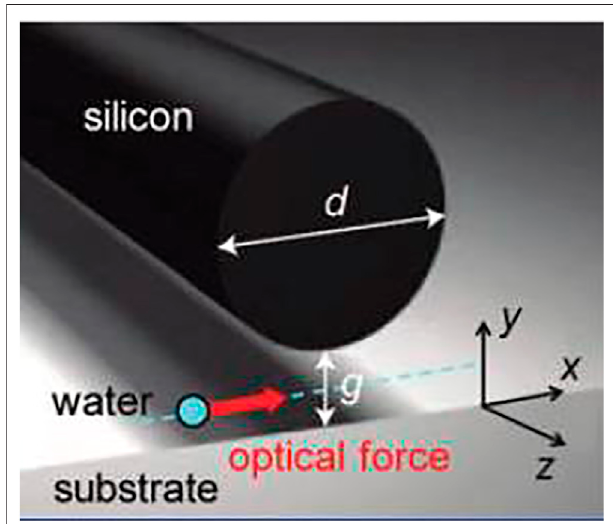
FIGURE 2 | Image showing the silicon waveguide separated by a sub-micrometer gap to a metal substrate, showing the optical force applied to the nanoparticles (Complete with permission from Yang et al. (2011). Copyright 2011 American Chemical Society).